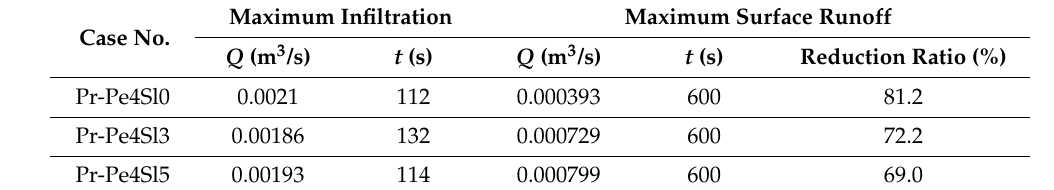
Figure 17. Comparison of structure variation: ( a ) infiltration; ( b ) surface runoff. Table 8. Results of slope variation.